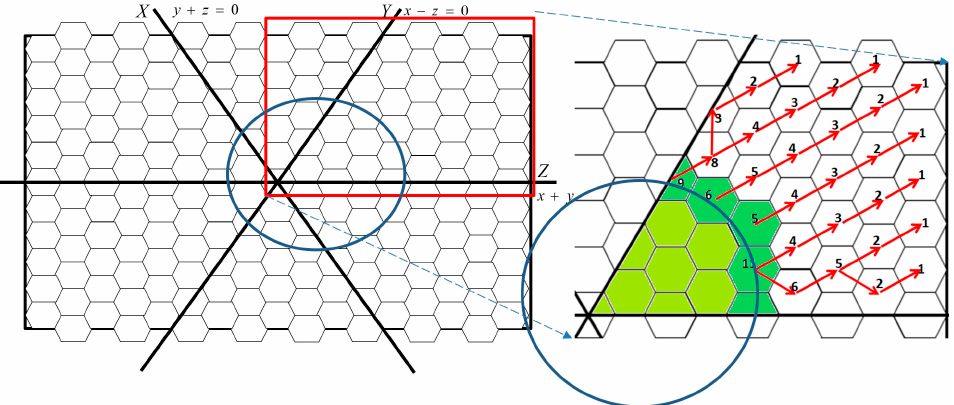
Figure 6. Directions and amount of energy being transmitted downstream. The numbers represent the amount of transmitted energy. The green cells are in the movement region, in addition, the intersection of movement and transmission regions is in those darker green cells.